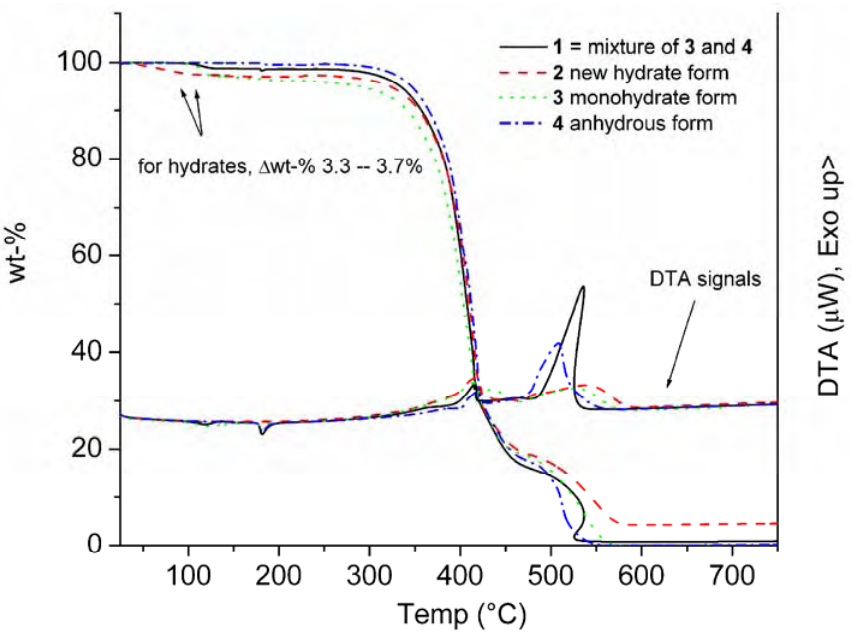
Figure 7. TG and DTA curves for the solids 1 - 4 measured with heating rate of 10 °C min -1 .